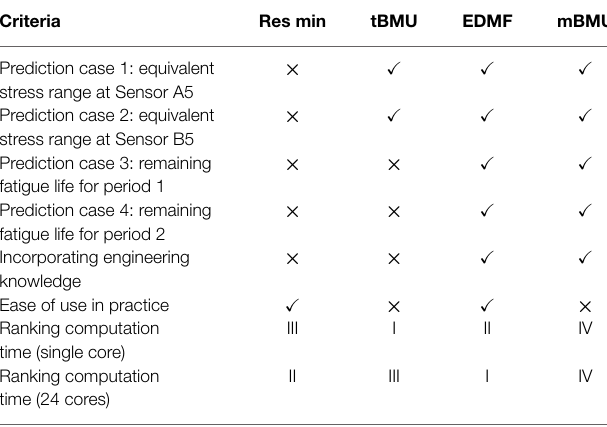
The checks indicate satisfactory performance while the crosses indicate unacceptable performance. The roman numerals used for the last two criteria are rankings where I is the best.